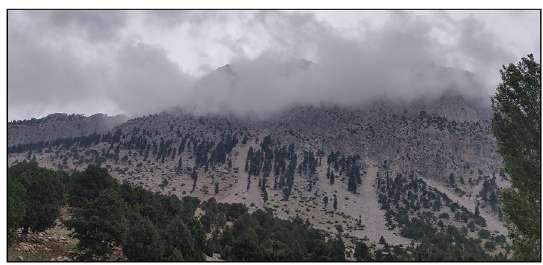
Fig. 9 Dagdibi represents a typical reflection of the Mediterranean mountain climate recorded in the mountain environment, represented by cool summers with rare orographic precipitation and snowy and cold